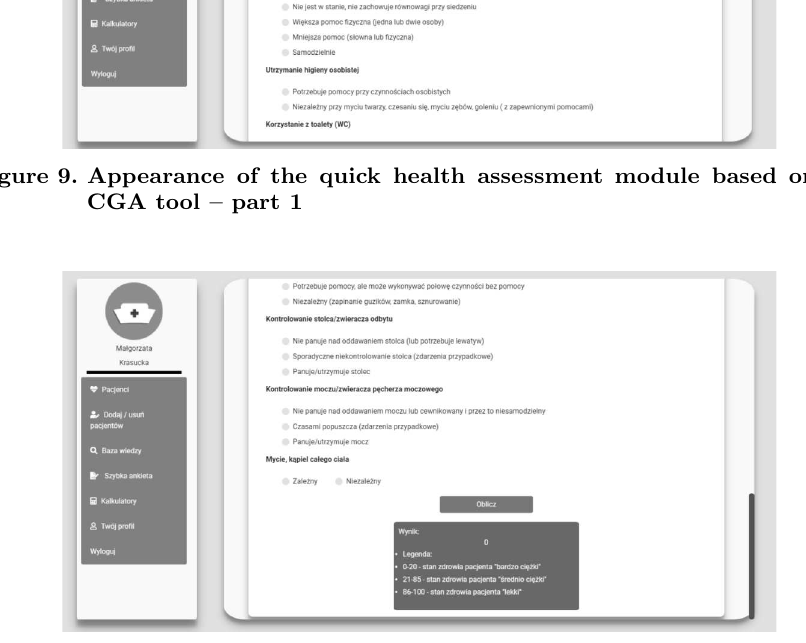
Figure 10. Appearance of the quick health assessment module based on the CGA tool – part